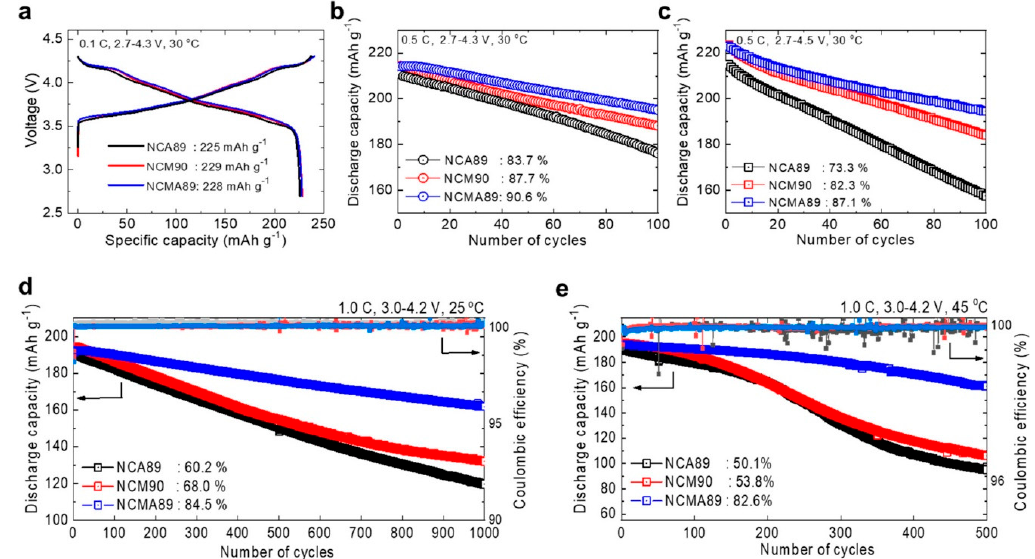
Figure 11. Comparison of electrochemical performance of the NCA89, NCM90, and NCMA89 cathodes in half ‐ cells with Li metal anode. ( a ) First cycle voltage profiles for the three cathodes at 0.1C at 30 °C. Cycle ability of the three cathodes were tested in voltage ranges of ( b ) 2.7–4.3 and ( c ) 2.7–4.5 V at 0.5C and 30 °C. Long ‐ term cycling performance of the NCA89, NCM90, and Li[Ni 0.89 Co 0.05 Mn 0.05 Al 0.01 ]O 2 (NCMA89) cathodes using pouch full cells at 1C and ( d ) 25 and ( e ) 45 °C with a voltage range of 3.0–4.2 V with mesocarbon microbead graphite as an anode. Reproduced with permission from [246]. Copyright 2019 The American Chemical Society.